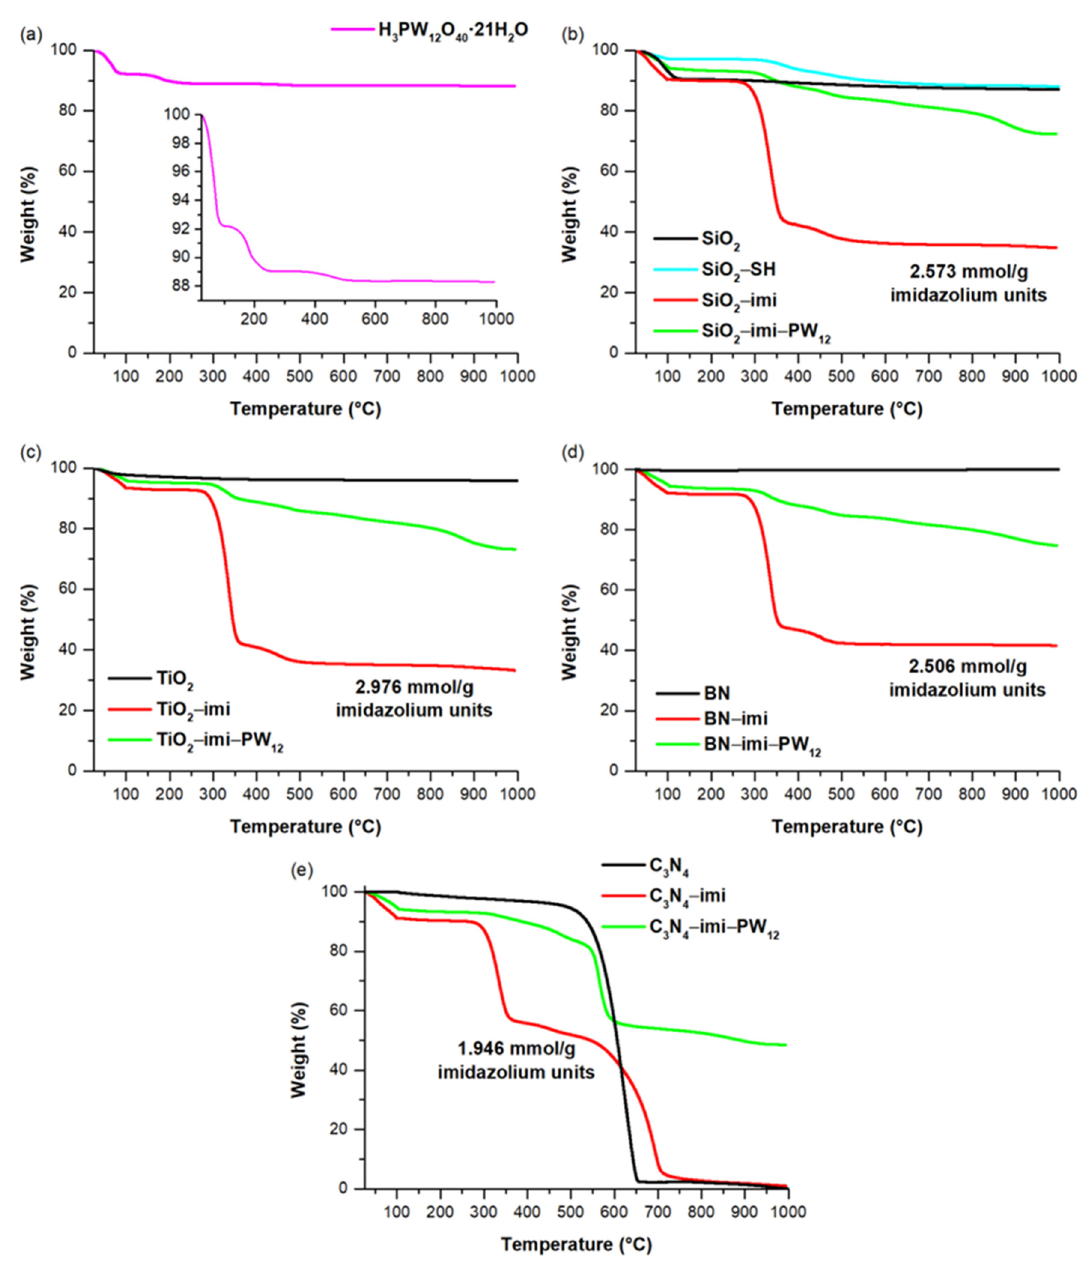
Figure 3. TGA under N 2 of ( a ) H 3 PW 12 O 40 · 21H 2 O, ( b ) SiO 2 − imi and SiO 2 − imi − PW 12 , ( c ) TiO 2 − imi and TiO 2 − imi − PW 12 , ( d ) BN − imi and BN − imi − PW 12 , and ( e ) C 3 N 4 − imi and C 3 N 4 − imi − PW 12 .